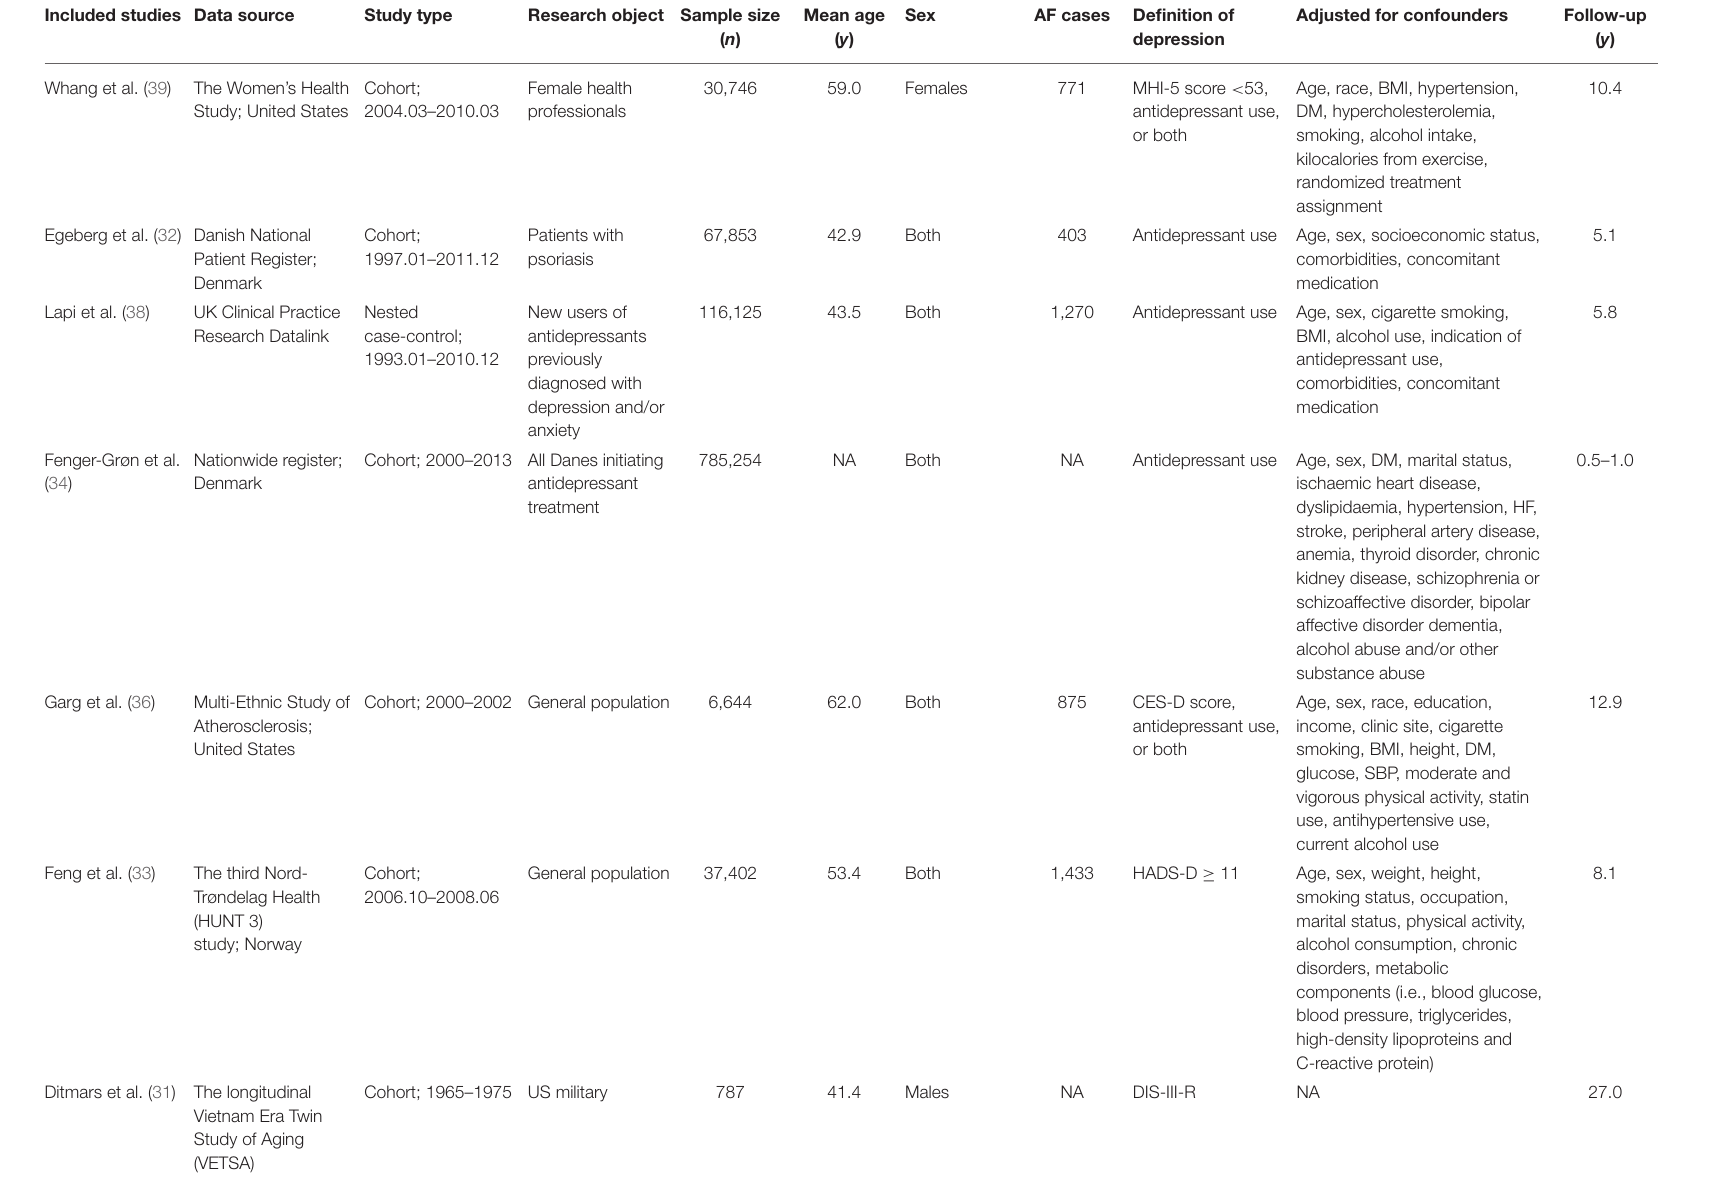
TABLE 1 | Baseline patient characteristics of included